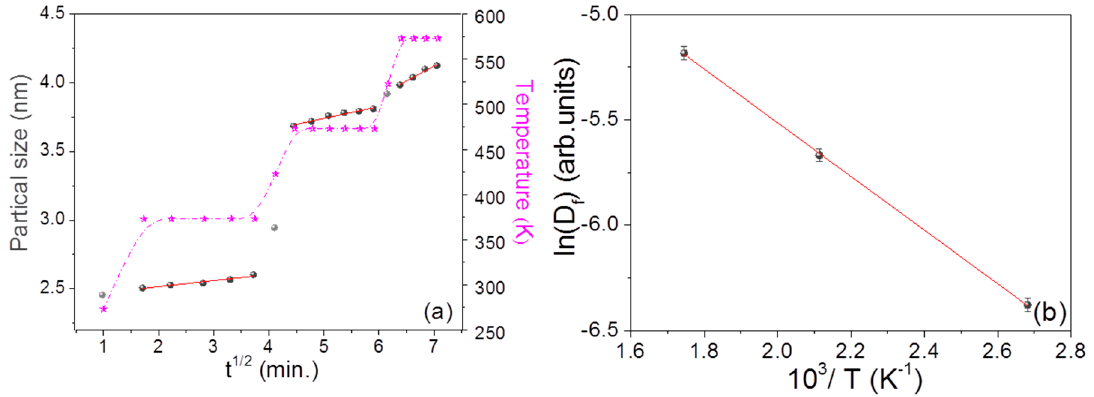
(cid:16) √ (cid:17) t at varying